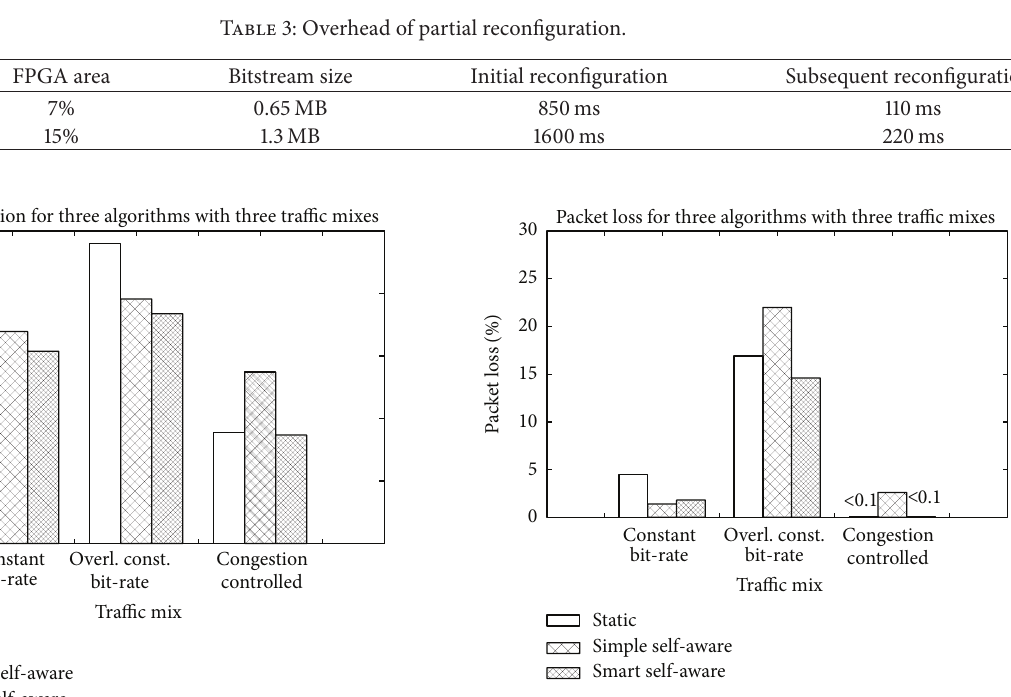
Figure 10: CPU utilization for all combinations of mapping algo- rithms and network traffic mixes.